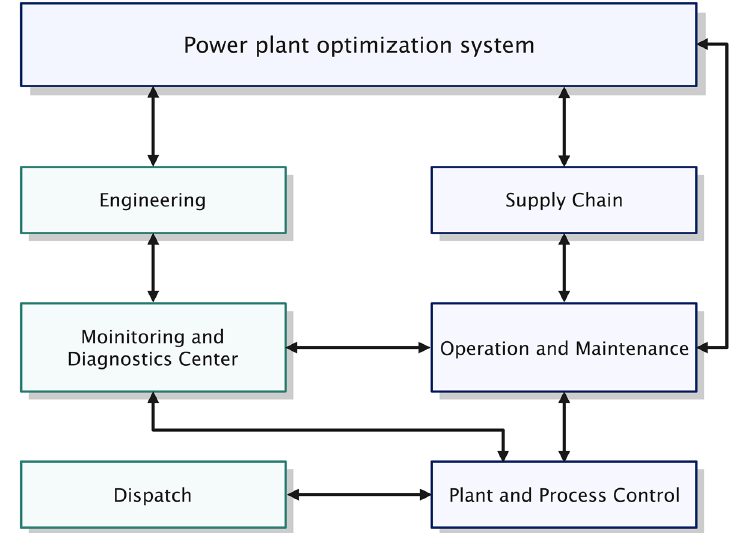
Fig. 5 EPRI I4GEN project